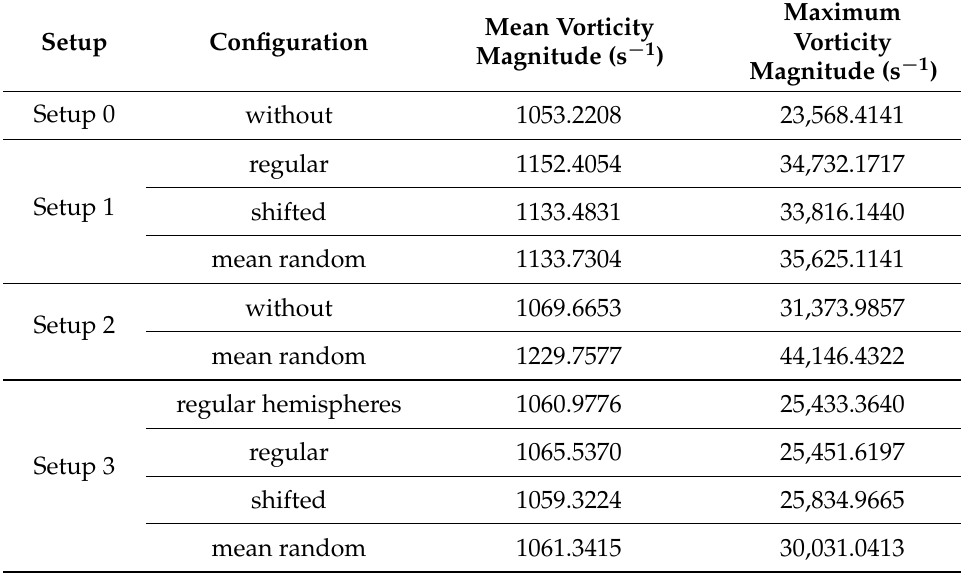
Table 5. Vorticity results for all setups and